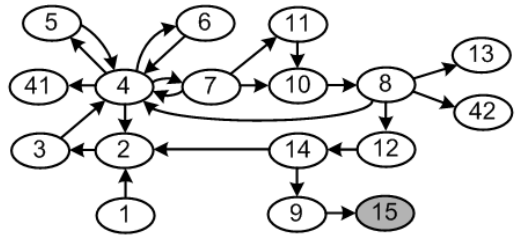
Fig. 1. Topological space of the solution domain on high level of